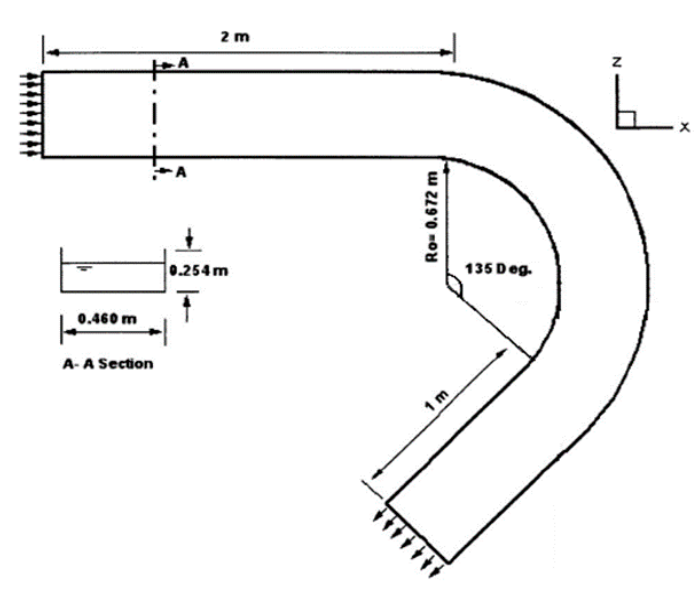
runs were compared to the corresponding observed results.